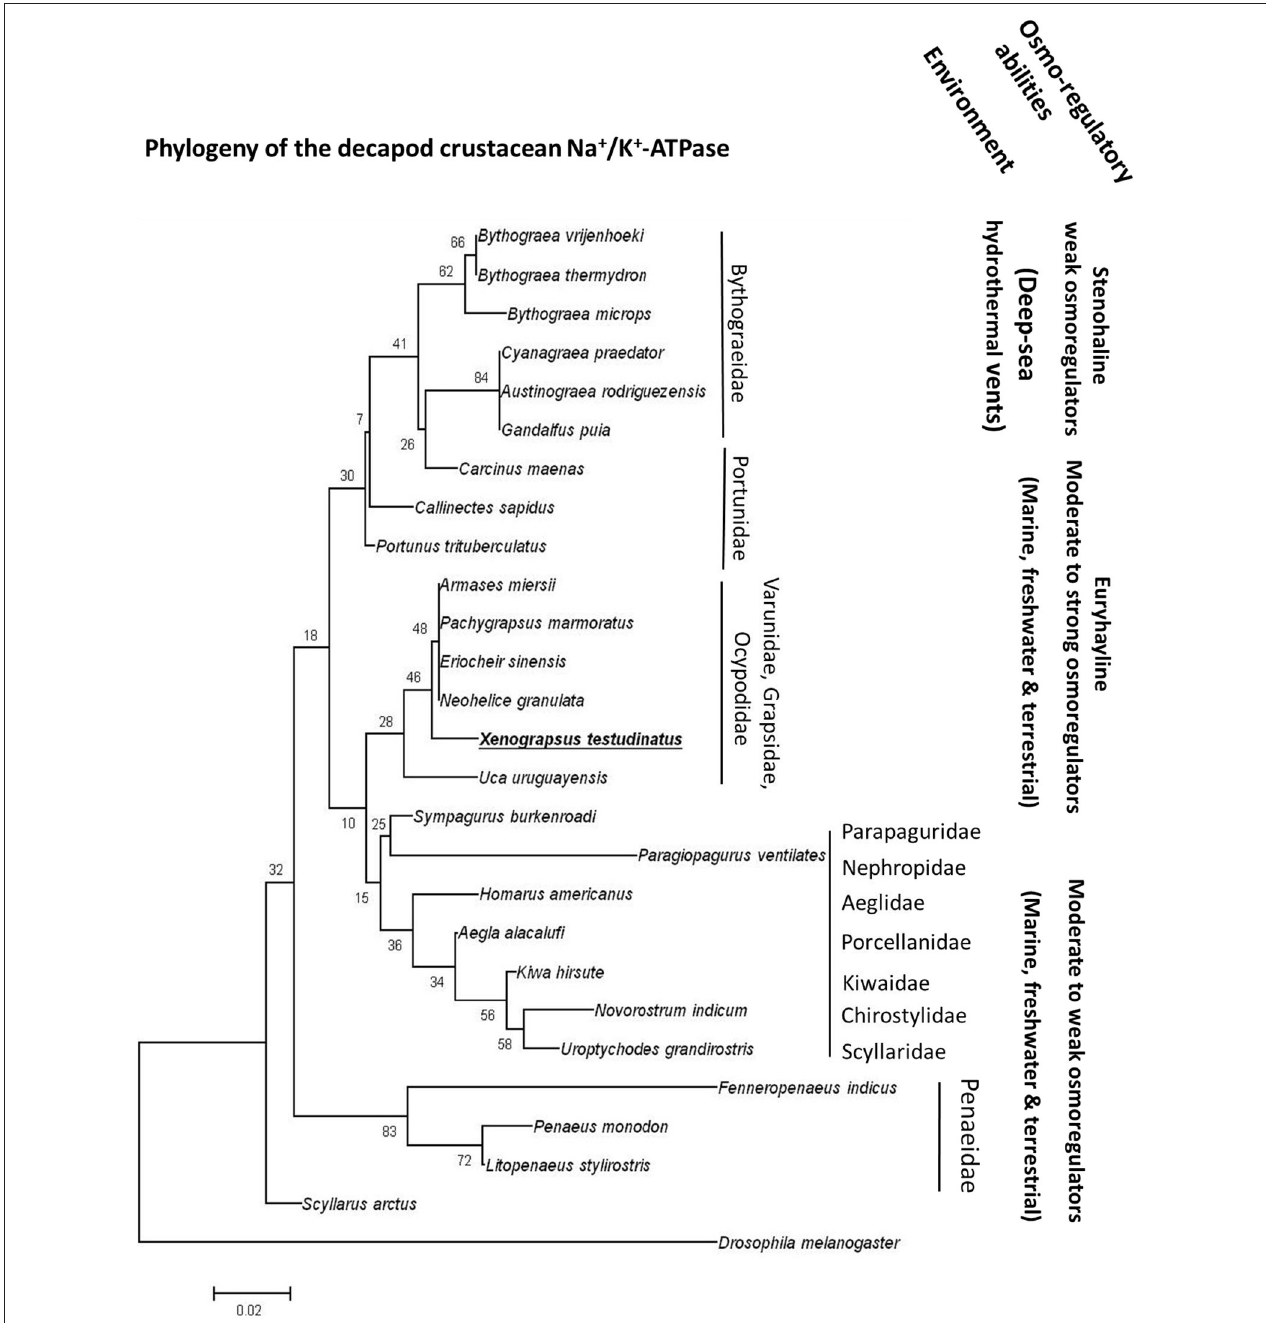
FIGURE 5 | The phylogeny of crustacean Na + /K + -ATPases. Routed phylogenetic tree of deduced Na + /K + -ATPase amino acid sequences from different decapods crustaceans. Numbers indicate bootstrap values and accession numbers for the sequences are provided along with species names. Information regarding the habitat and osmoregulatory abilities of the different species is included in the phylogenetic tree.